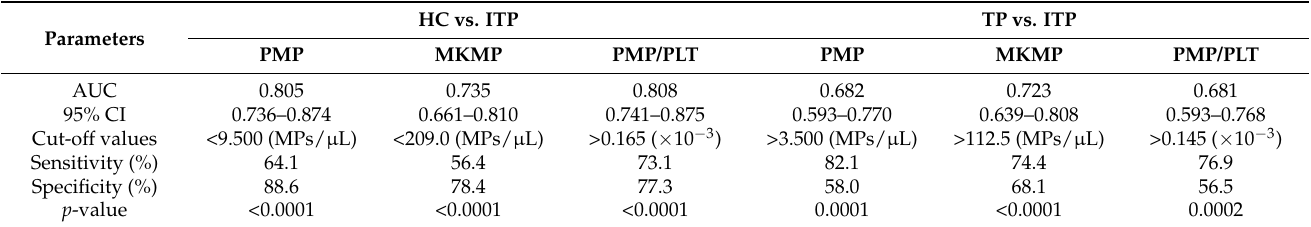
Table 2. ROC analysis of plasma MP levels for ITP differential diagnosis.